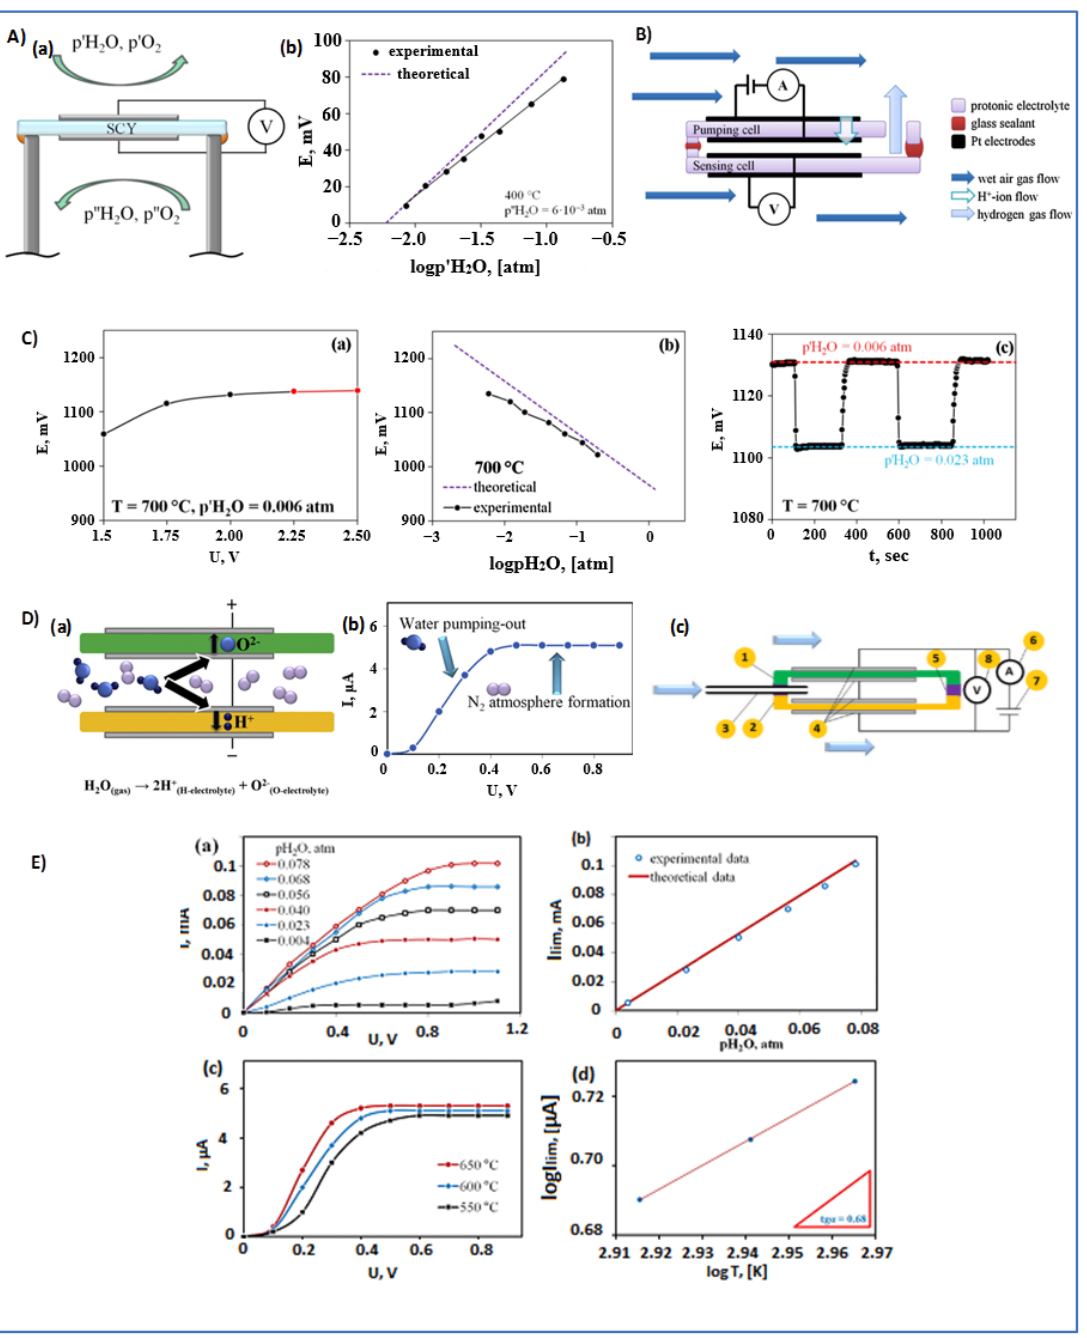
Figure 8. ( A ) (a) Scheme of the humidity sensor fabricated by Iwahara et al.; (b) theoretical and experimental E(mV)-log(p H2O ) plot at 400 °C. Reproduced with permission from [70]. ( B ) Configu- ration of the humidity sensor designed by Katahira et al. (Reproduced with permission from [71]). ( C ) Electric potential as a function of applied voltage (a) and H 2 O (b) vapor content at 700 °C; (c) E(mV)-t(sec) for cyclical changes in p’ H2O (Reproduced with permission from [8]). ( D ) (a) Reactions